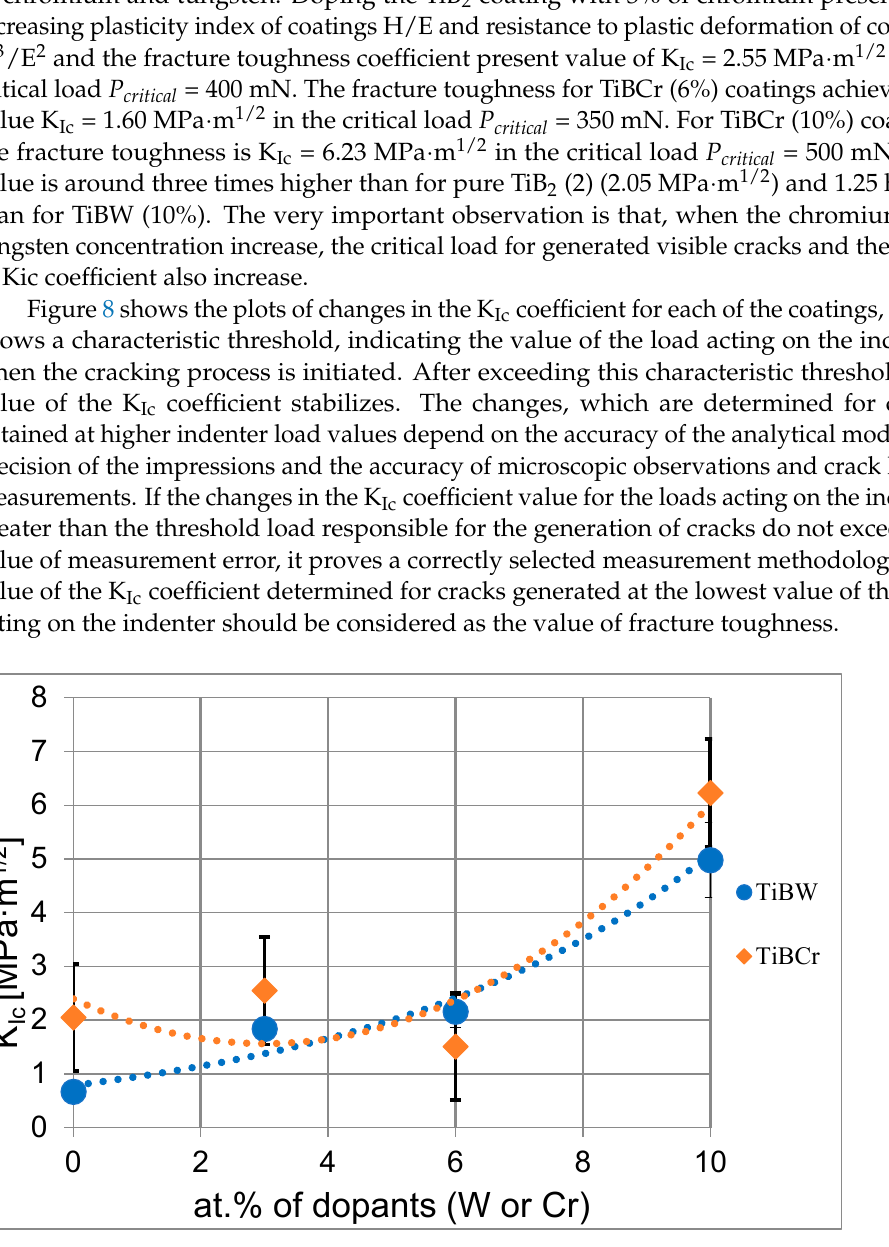
Figure 8. The results of the fracture toughness K Ic analysis for a series of TiBW coatings (blue) and for a series of TiBCr coatings (red) depends on the concentrations of dopants (W or Cr).